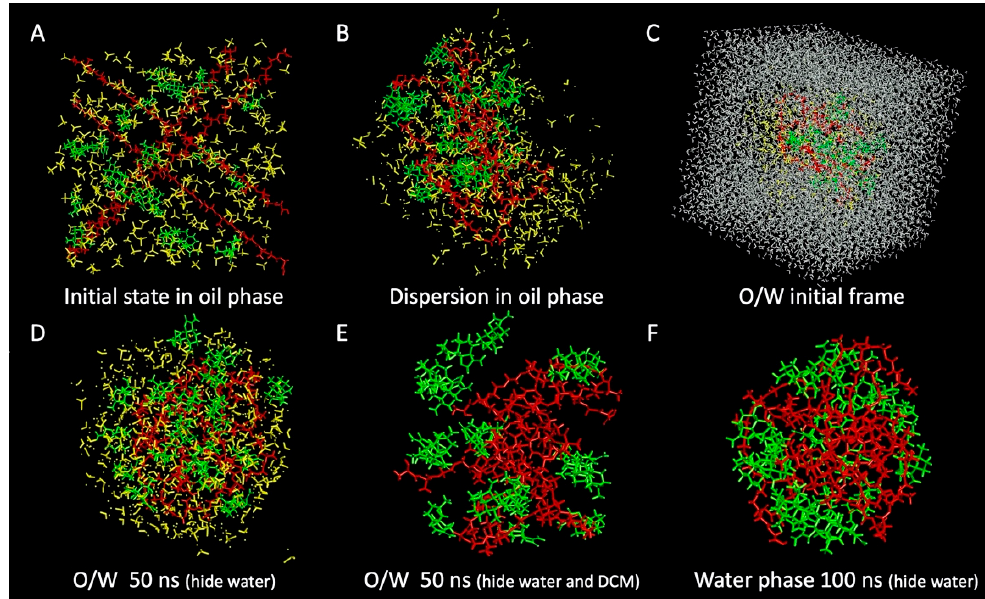
Figure 4. Snapshots of MD simulations of ABMs in the oil phase at ( A ) 0 and ( B ) 1 ns, in the O/W system at ( C ) 0 and ( D , E ) 50 ns, in the water phase at ( F ) 100 ns. Green molecules: AB; red molecules: PLGA; yellow molecules: DCM; gray molecules: water.